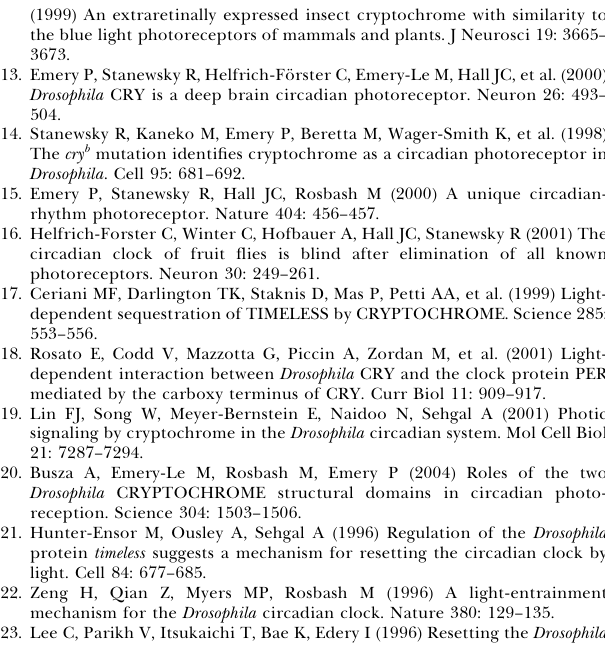
Figure S1. 37 8 C Heat Pulses Result in Robust Phase Shifts of Wild- Type and per L Flies but Not of cry b or per L ; cry b Flies